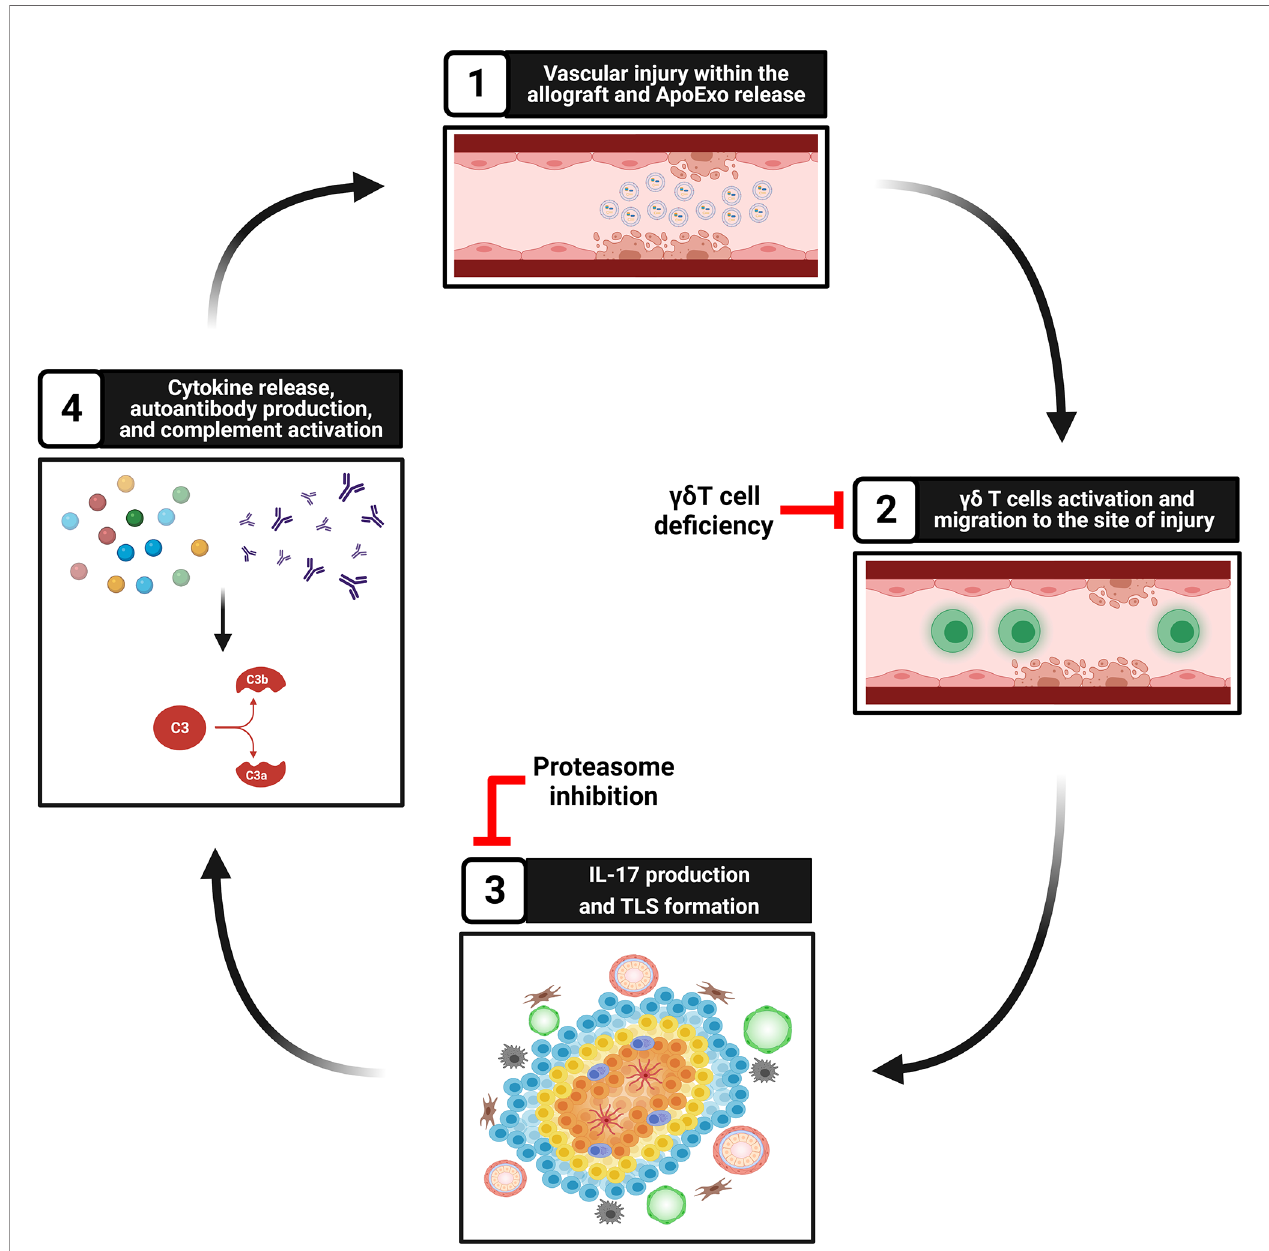
FIGURE 2 | Tissue injury, ApoExo release, and TLS formation. Step 1: Vascular injury and apoptosis of endothelial cells foster the release of apoptotic exosome-like vesicles (ApoExo) carrying active 20S proteasome. Step 2: ApoExo activate gd T cells that migrate to the site of injury. Genetic de fi ciency of gd T cells decreases TLS formation and autoantibody production. Step 3: gd T cells produce IL-17 and favor the formation of tertiary lymphoid structures at sites of injury. Inhibition of proteasome activity within ApoExo blocks TLS biogenesis and autoantibody formation. Step 4: Tertiary lymphoid structures produce proin fl ammatory cytokines and autoantibodies, therefore favoring complement activation and further vascular